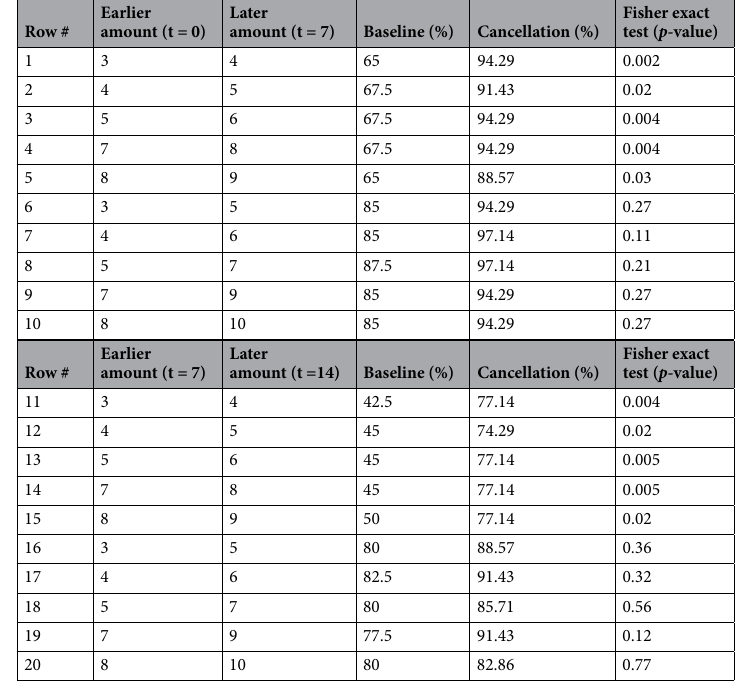
Table 1. Stimuli and results from Experiment 2 (gains). Percentages indicate the percent of participants choosing the larger later